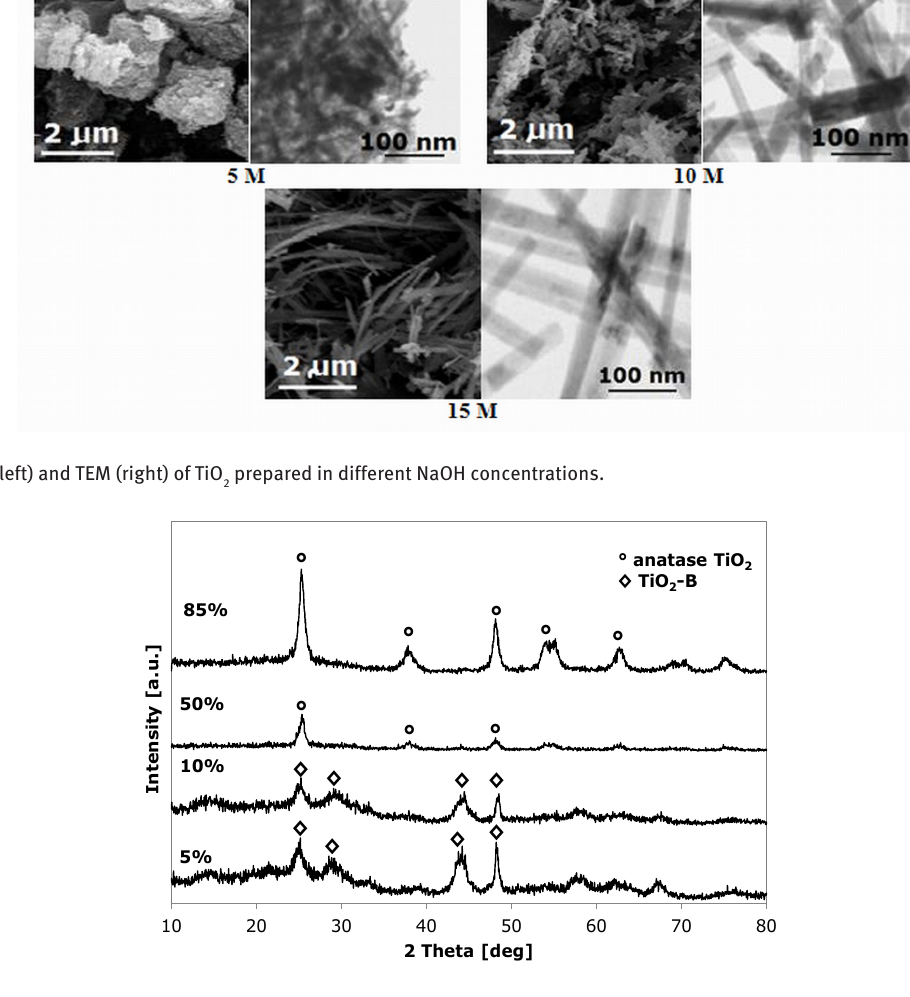
Figure 8: XRD of materials prepared with different autoclave filling fractions.